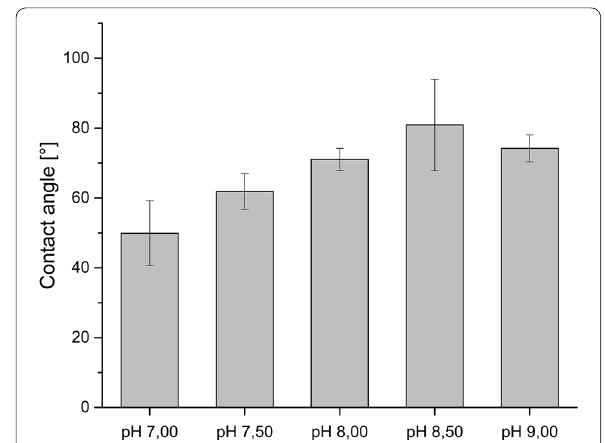
Fig. 2 Resulting water contact angles of B. subtilis spores cultivated at different pH